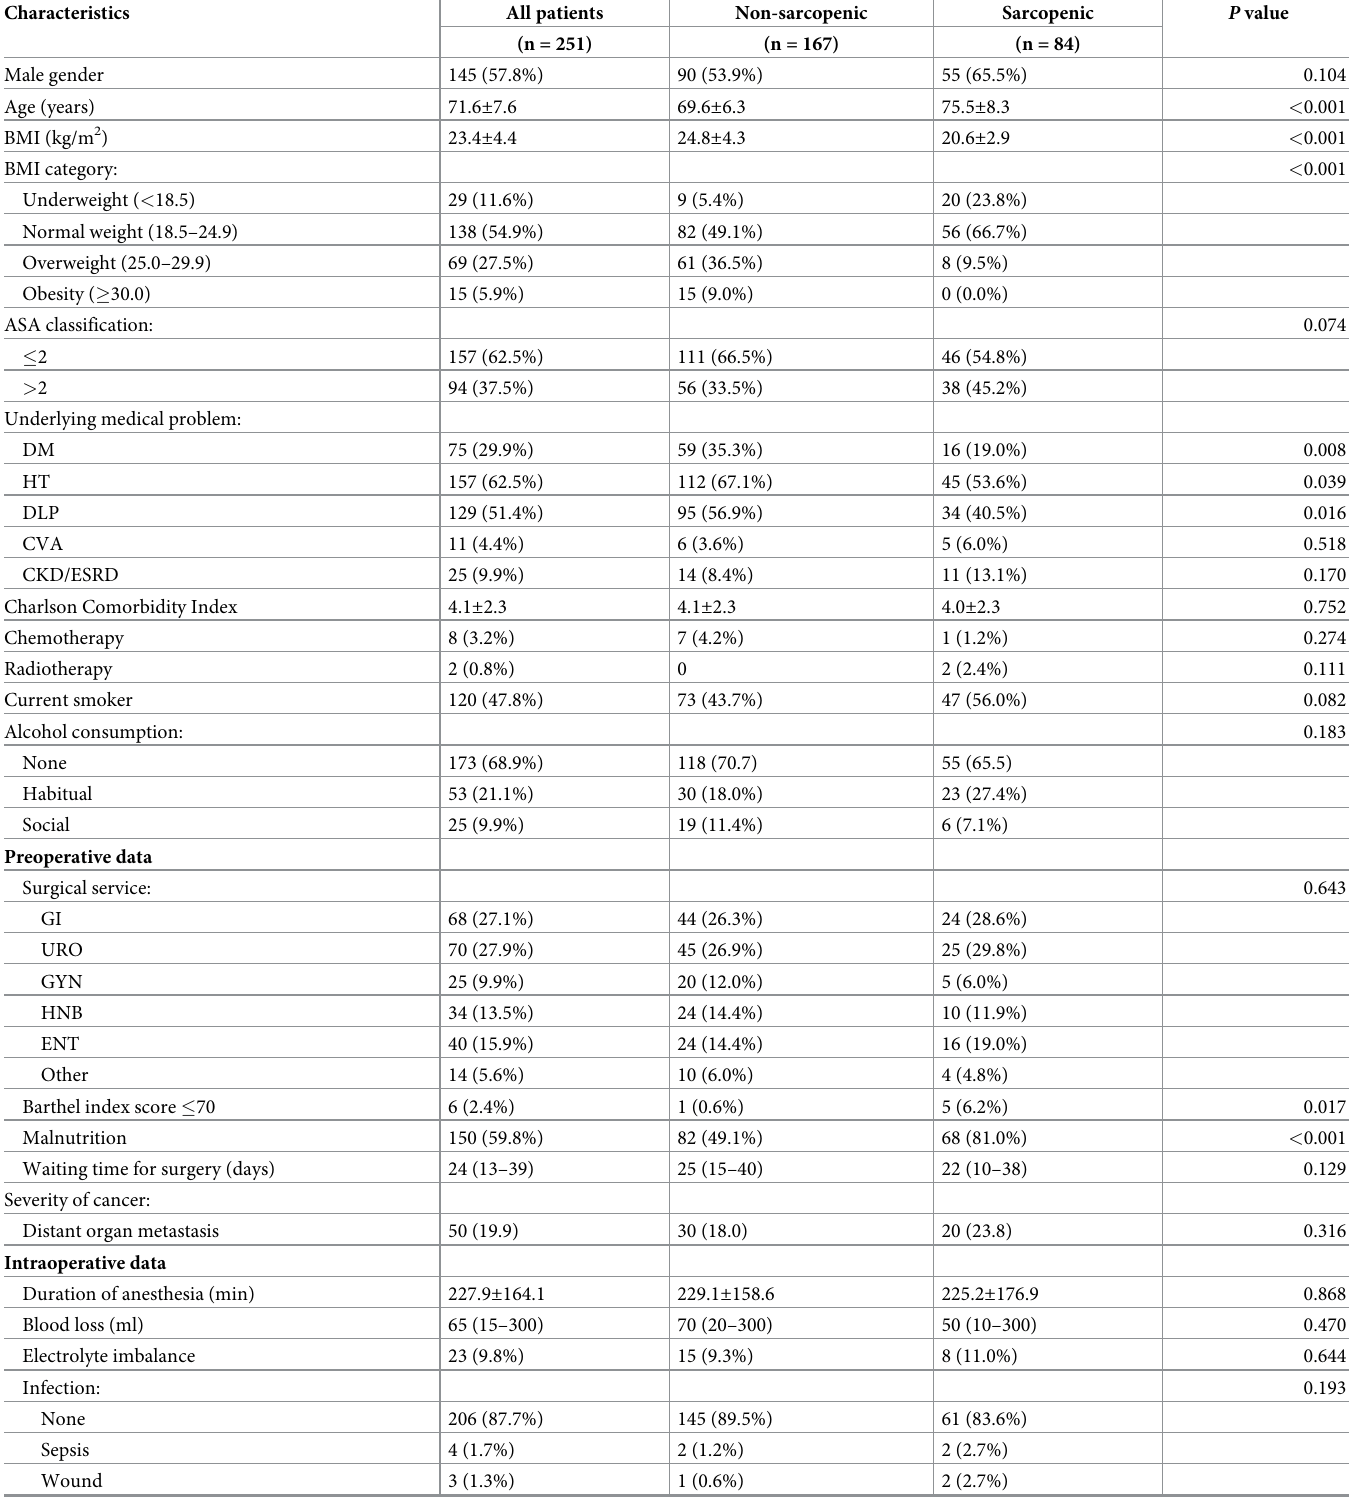
Table 2. Demographic, clinical, and surgical characteristics and outcomes.